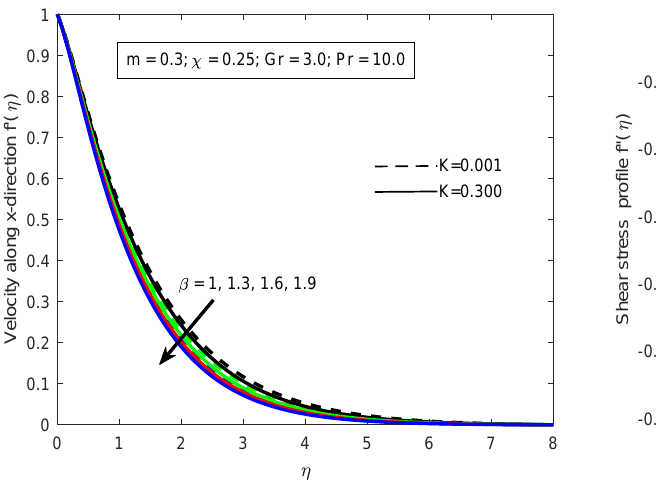
Figure 10: Variation of velocity profile in the x − direction with Casson fluid parameter